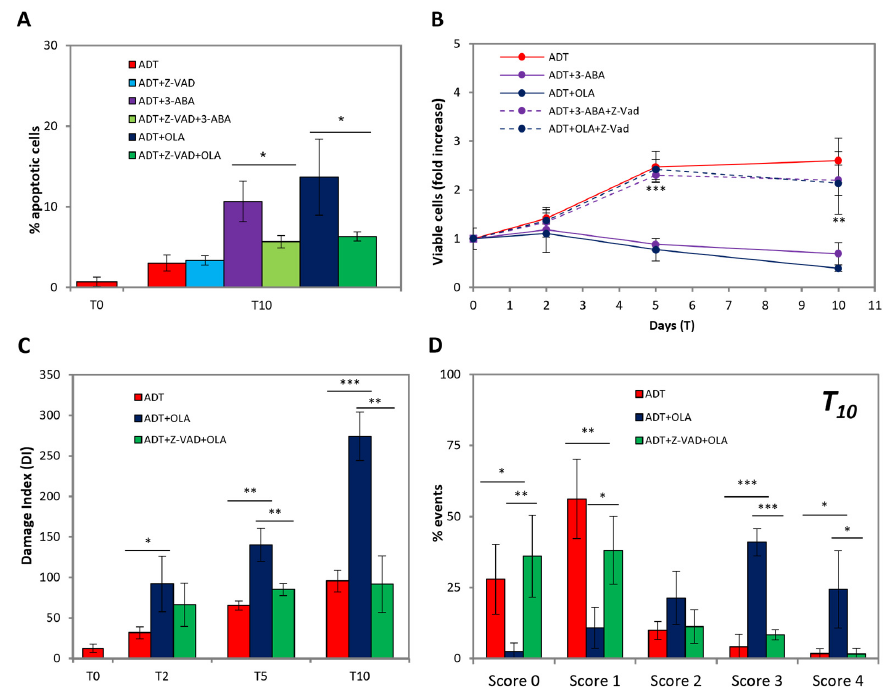
Figure 5. PARPi-induced apoptosis is caspase-dependent. ( A ) The increased apoptotic rate, induced by PARP inhibitors, is reverted by the caspase inhibitor Z-VAD: histogram shows the apoptotic extent at the indicated time points. Statistical significance was calculated via Student’s t -test. * p < 0.05. ( B ) Caspases inhibition reverts the cytotoxic effect of PARPi on ADT-treated cells. The profile shows the kinetics of viable (trypan blue-excluding) cell number expressed as fold over T0. Statistical significance was calculated via Student’s t -test. ** p < 0.01 and *** p < 0.001, with respect to ADT-treated cells + 3-ABA/OLA. ( C , D ) Caspase inhibition reverts PARPi-induced DNA damage, increasing the fraction of cells with low or null DNA damage. Comet assay of ADT-treated LNCaP cells + OLA ± Z-VAD. The histograms report the Damage Index ( C ) or the percentage of events in each damage categories ( D ) at the indicated time points. Statistical significance was calculated via Student’s T -test. * p < 0.05, ** p < 0.01 and ** p < 0.001.